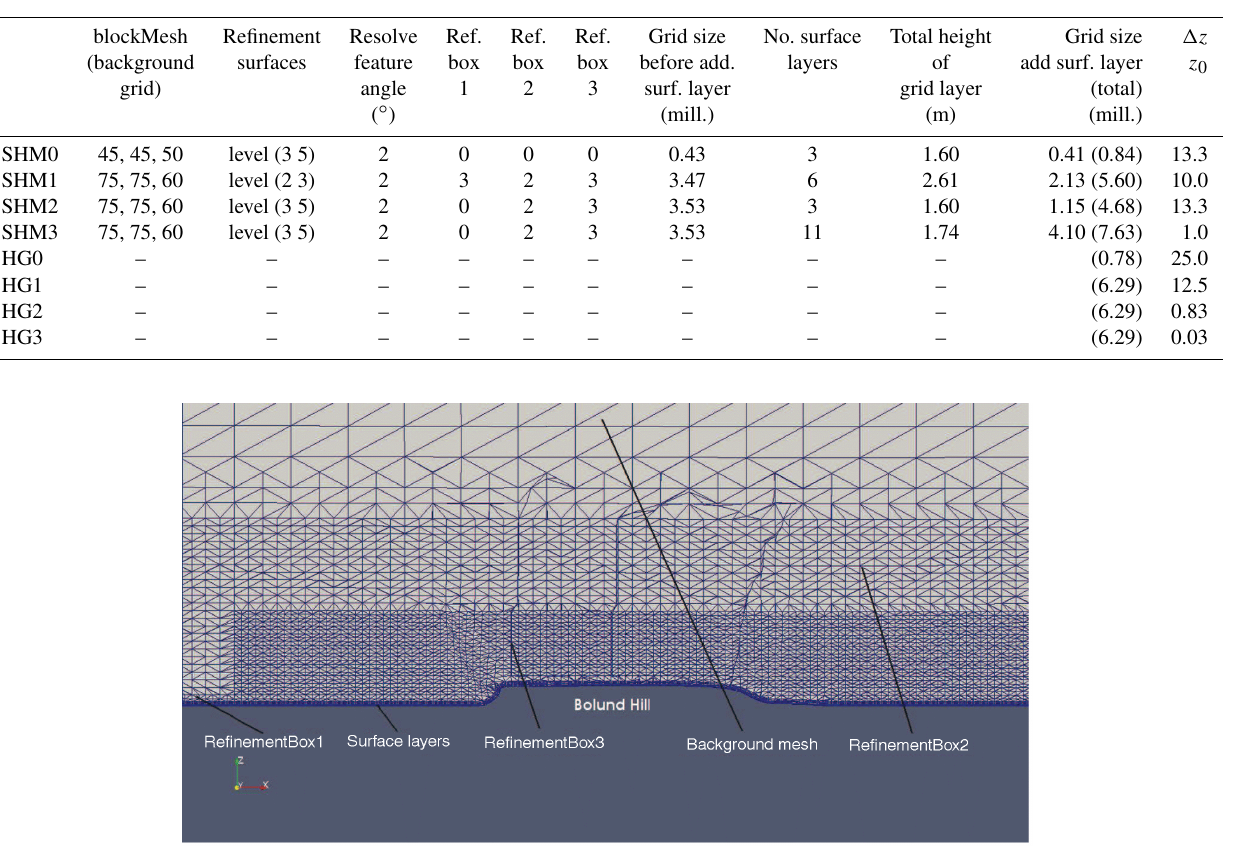
Figure 8. Bolund Hill: cross section of the grid created by SnappyHexMesh. Three refinement boxes together with variations in the number of surface layers indicated in the figure are used as a basis for generation of the grids described in Table